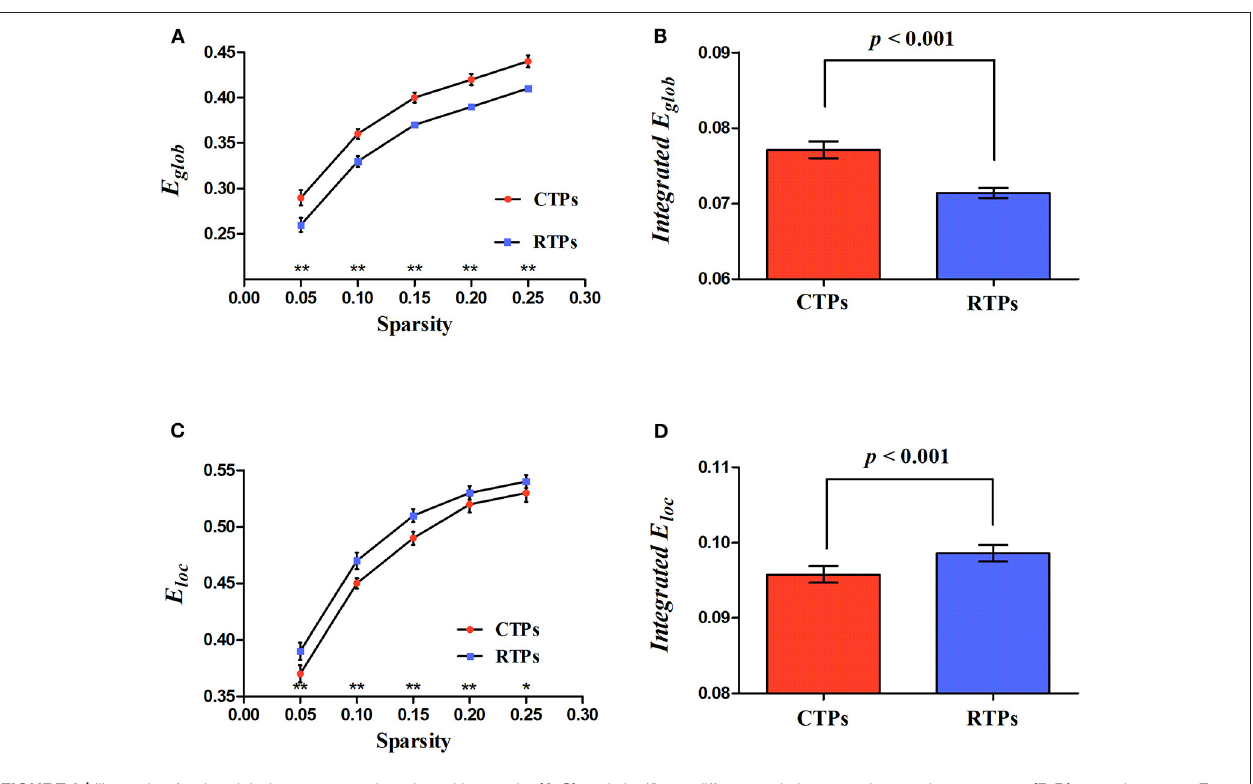
Frontiers in Human Neuroscience |